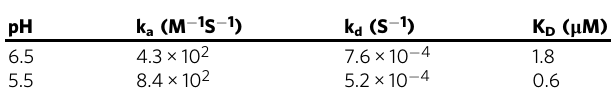
Table 1 Summary of kinetic data of cystatin C – heparin interactions from